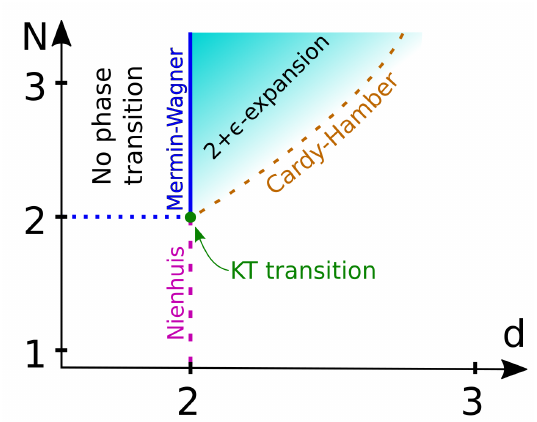
Figure 1: (Color online) The ( d , N ) plane in the vicinity of the Kosterlitz-Thouless (KT) point ( 2,2 ) , schematically illustrating the landscape of universality classes with some of its most characteristic features. The Mermin-Wagner line separates the re- gions with possible and impossible symmetry-breaking phase transitions for N > 2. The critical exponents are expected to be non-analytical across the Cardy-Hamber line, which separates the regimes characterized by irrelevant ( N large) and relevant ( N small) vortices. Exact expressions for the ν − 1 and η exponents are available along the Nienhuis line [ d = 2, N ∈ ( − 2,2 ) ] as well as in the limit N → ∞ for d > 2. The region corresponding to d < 2 and N < 2 [ 9 ] is not discussed in the present